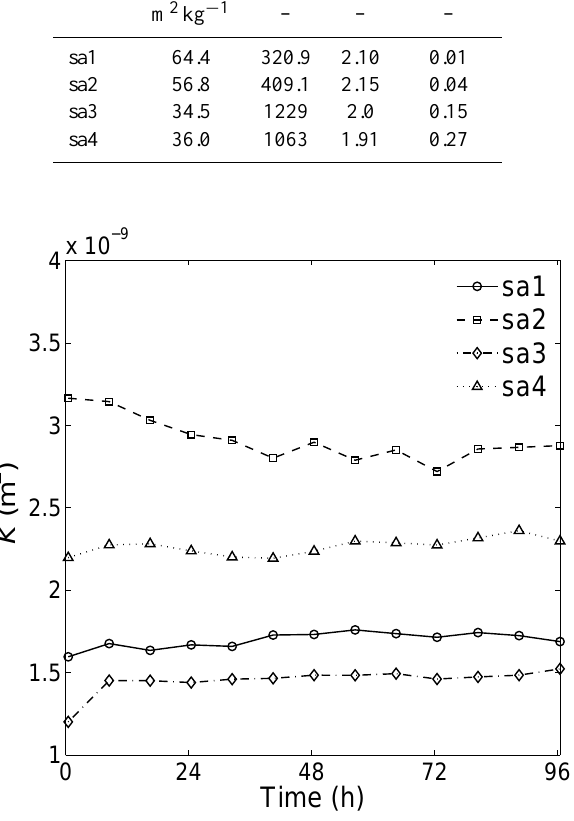
Figure 11. Temporal evolution of the effective permeability by ap- plying DPLS with an uncertainty of 16% (Zermatten et al.,